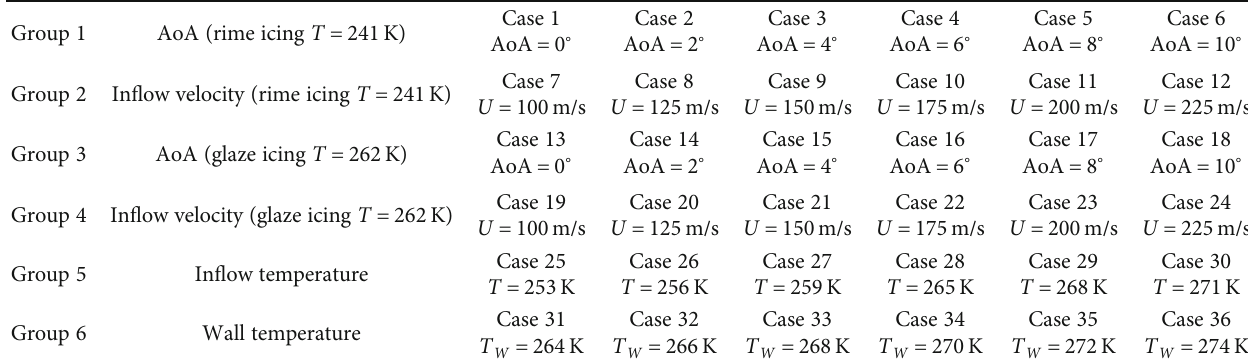
Table 4: Ice accretion cases for the pitot-static